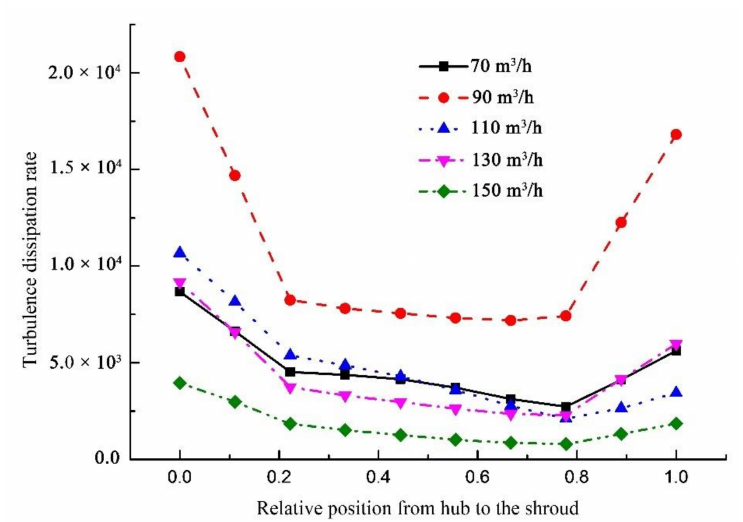
Figure 17. The variation of turbulence dissipation rate from the hub to the shroud of the first impeller outlet section of the multiphase pump under different flow